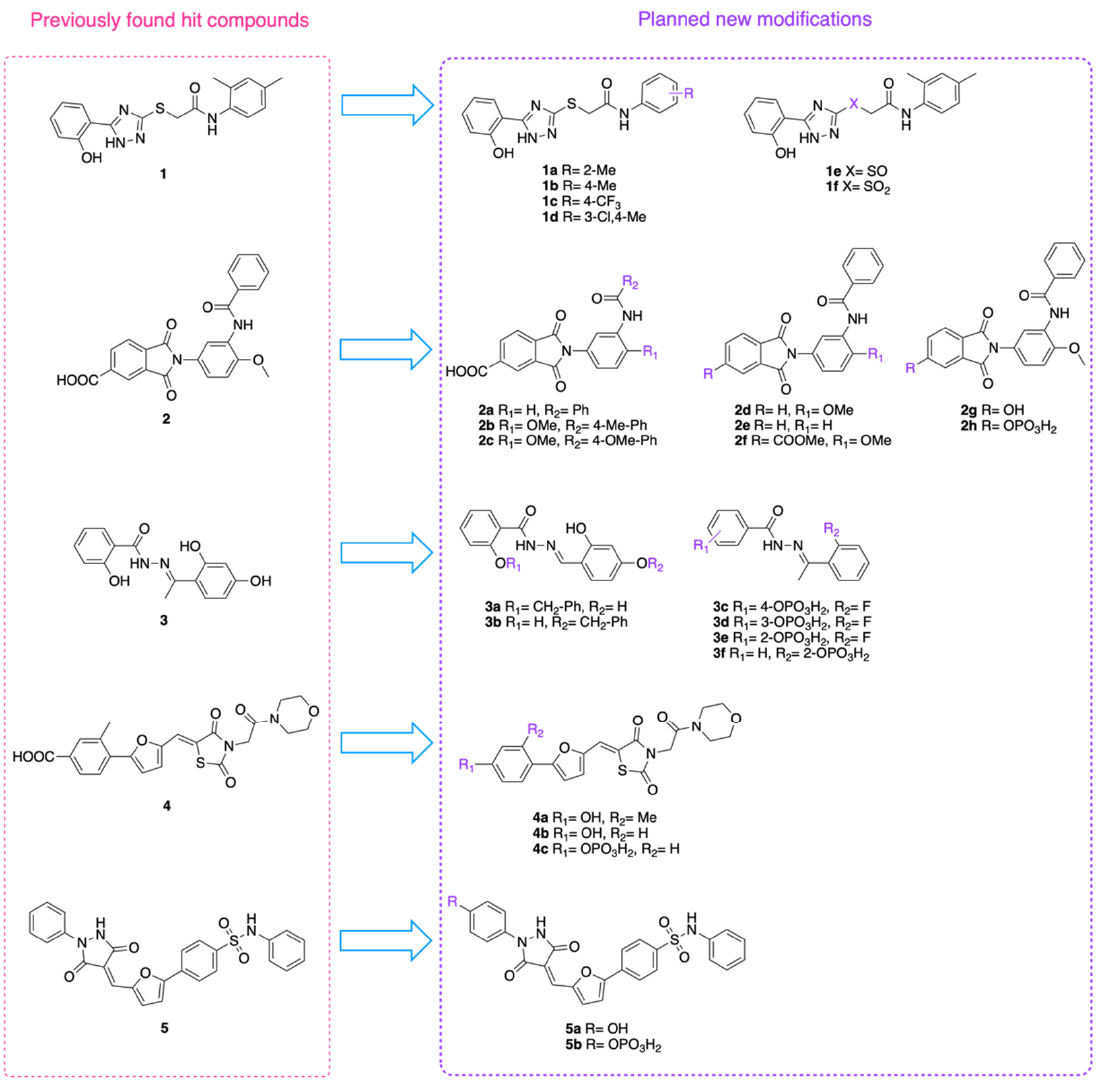
Figure 3. Summary of the planned structural modifications to the scaffolds of hit compounds 1 – 5